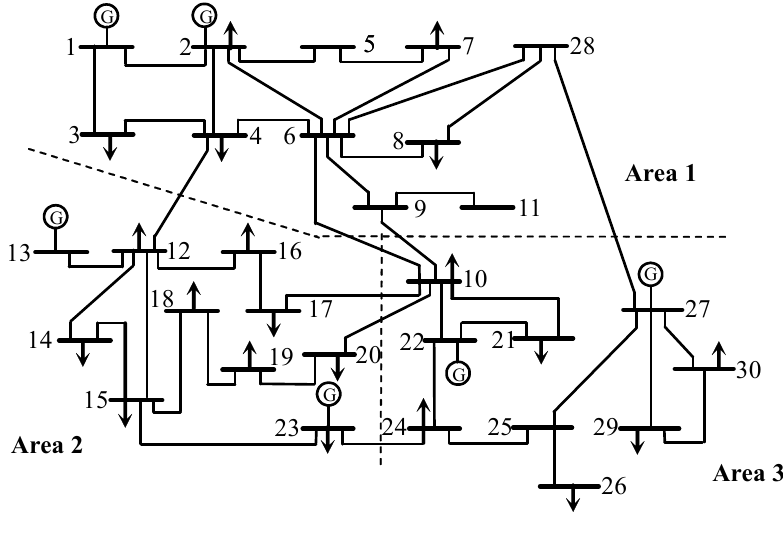
Figure 3. IEEE-30-bus